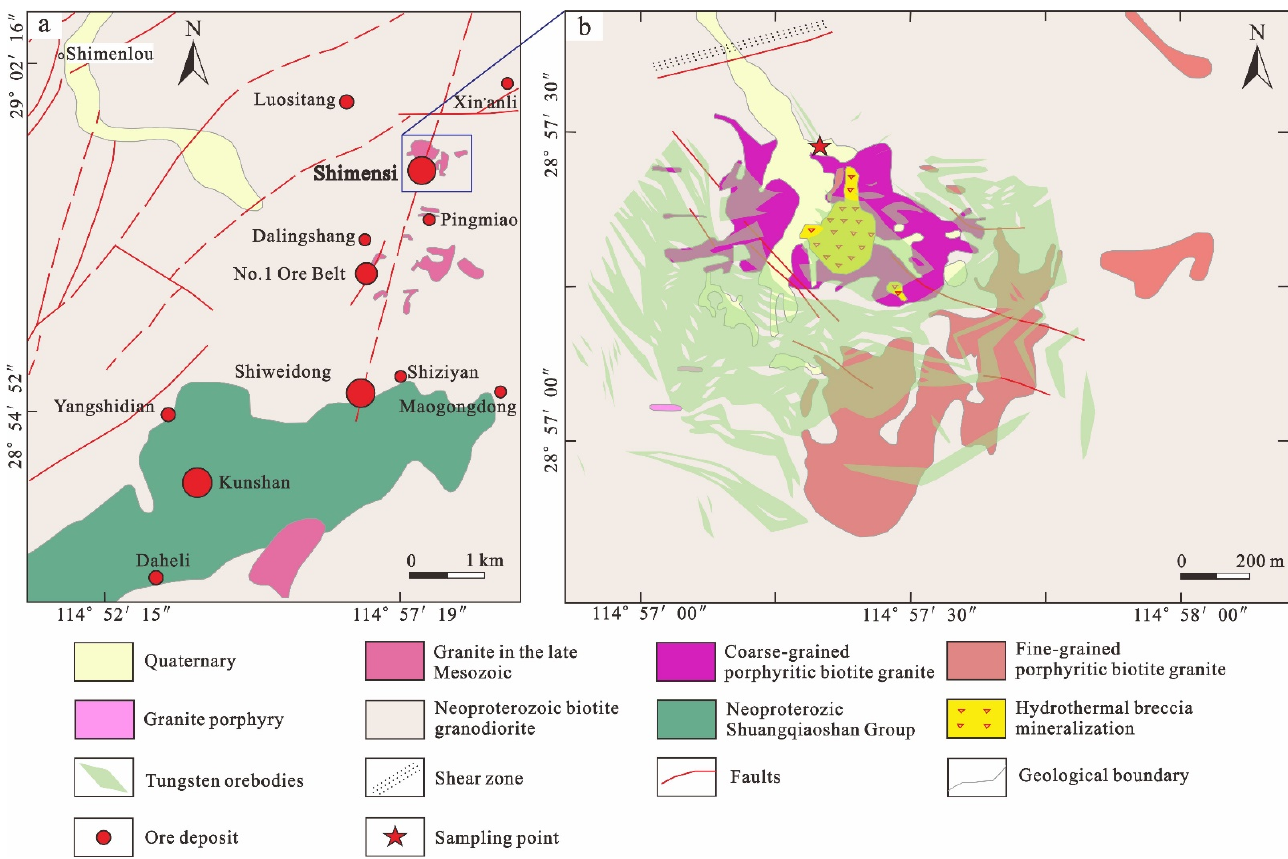
Figure 1. ( a ) Simplified geological map of the Dahutang ore field. ( b ) Geological map of the Shimensi mine (modified from